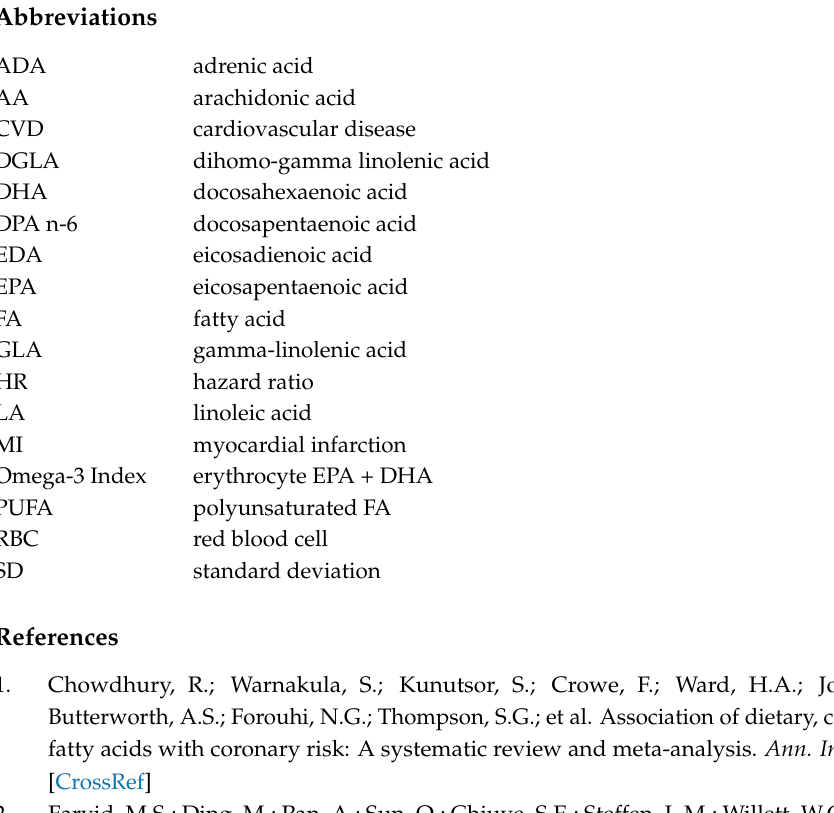
s1, Table S1: Correlation between and among red blood cell n-3 and n-6 fatty acids, Table S2: Distribution of outcomes ( n = 2500), Table S3: Risk of events and mortality by individual n-6 fatty acids ( n = 2500), Table S3a: Linoleic Acid—Unadjusted, Adjusted for demographics (Table 1 variables), and further adjusted for the Omega-3 Index (5-groups), Table S3b: Gamma-linolenic Acid, Table S3c: Eicosadienoic Acid, Table S3d: Eicosatrienoic Acid, Table S3e: Arachidonic Acid, Table S3f: Docosatetraenoic Acid, Table S3g: Docosapentaenoic Acid, Table S3h: n6 index (sum of all 7